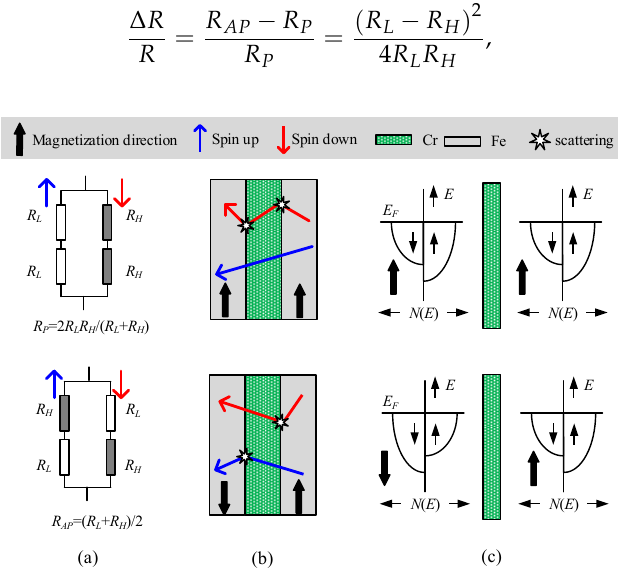
Figure 1. ( a ) Schematic of the resistor model; ( b ) Schematic of spin ‐ dependent scattering at the interfaces between ferromagnetic and non ‐ ferromagnetic layers with parallel magnetization (PM) and anti ‐ parallel magnetization (APM); ( c ) Schematic of density of electronic states with PM and APM. E , the electron energy; E F , the Fermi level; N ( E ), density of states.